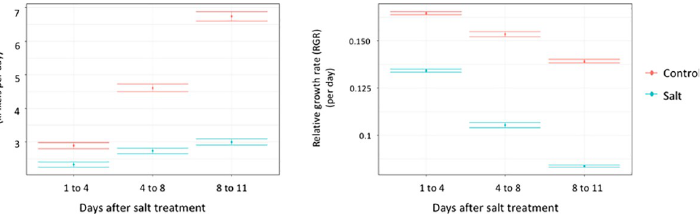
Fig 2. The effect of salt treatment on the traits measured at The Plant Accelerator 1 . Effect of salt on average absolute growth rate (AGR, left panel) and relative growth rate (RGR, right panel) for the three intervals 1–4, 4–8, and 8–11 days after salt treatment. Red and blue represent control and salt conditions, respectively. Error bars are ± standard